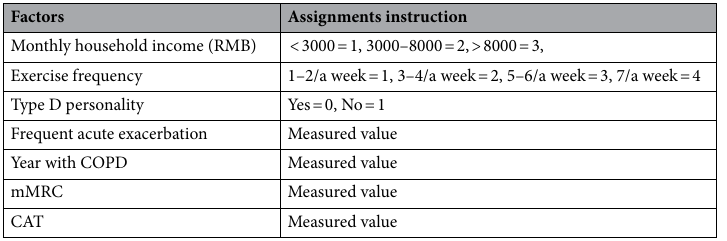
Table 4. Variables assignments.